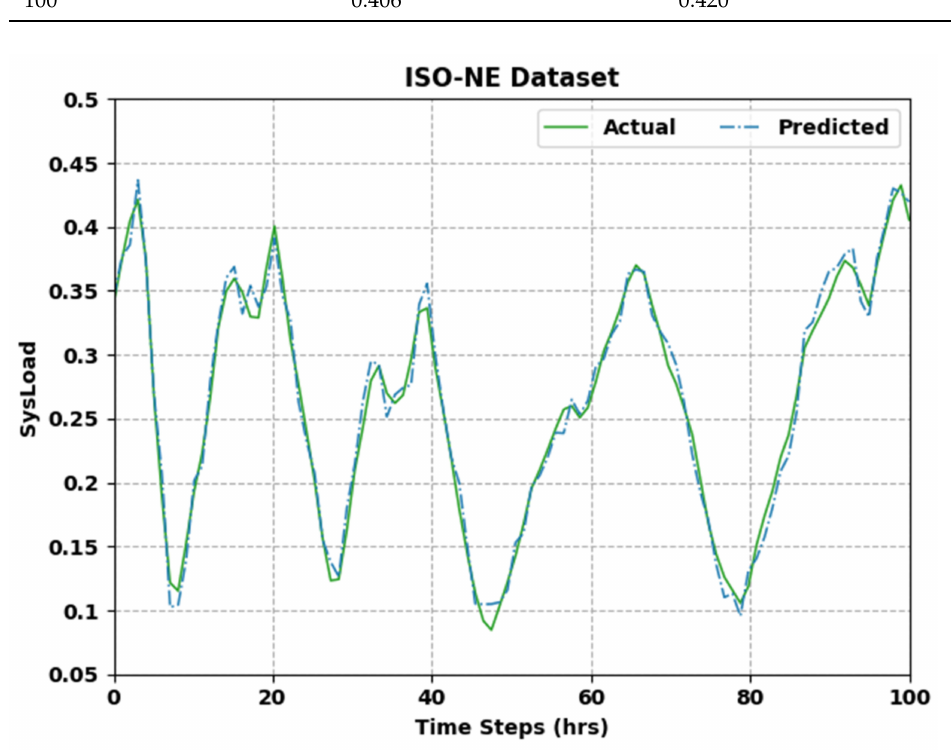
Figure 7. System load analysis of AJODL-DSSEM technique under ISO-NE